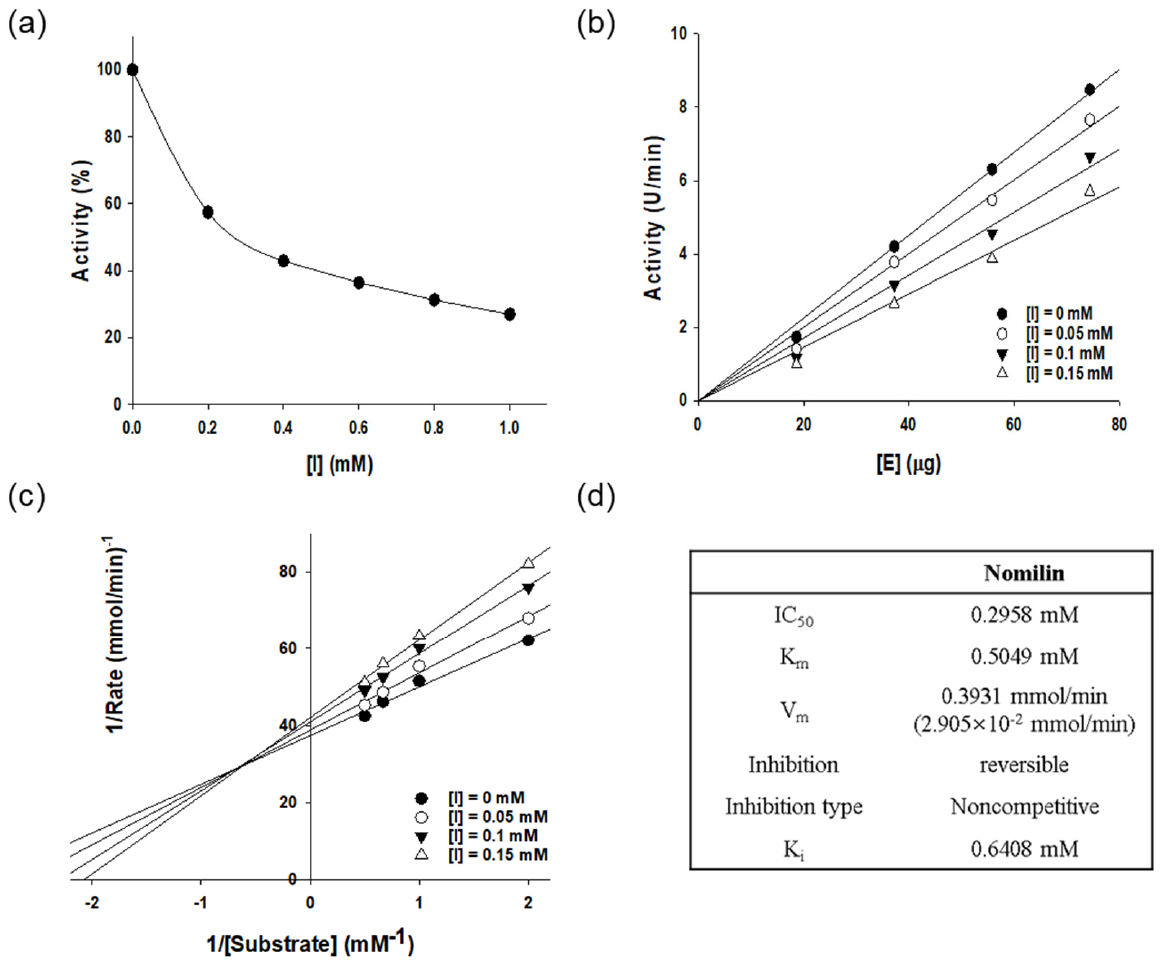
Figure 4. ( a ) Effect of nomilin on the activity of mushroom tyrosinase during the catalysis of L- DOPA (enzyme concentration 4.0 µg/mL). ( b ) Relationship between catalytic activity of mushroom tyrosinase and enzyme concentration at different concentrations of nomilin. Concentrations of nomilin for curves 1-4 were 0, 0.05, 0.1, and 0.15 mM, respectively. ( c ) Lineweaver-Burk plots for the nomilin-mediated inhibition of mushroom tyrosinase during the catalysis of DOPA at 30 °C and pH 6.8. Concentrations of quercetin for curves 1-4 were 0, 0.05, 0.1, and 0.15 mM, respectively; enzyme concentration was 4.0 µg/mL. The inset represents the plot of Kmapp versus quercetin concentration for determining the inhibition constant KI. ( d ) Kinetic parameters and microscopic inhibition rate constants of mushroom tyrosinase in the presence of nomilin.